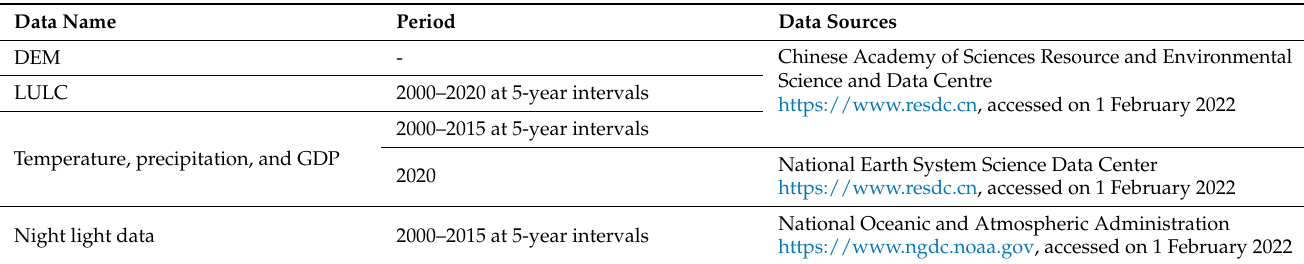
Table 2. Other data sources and periods.